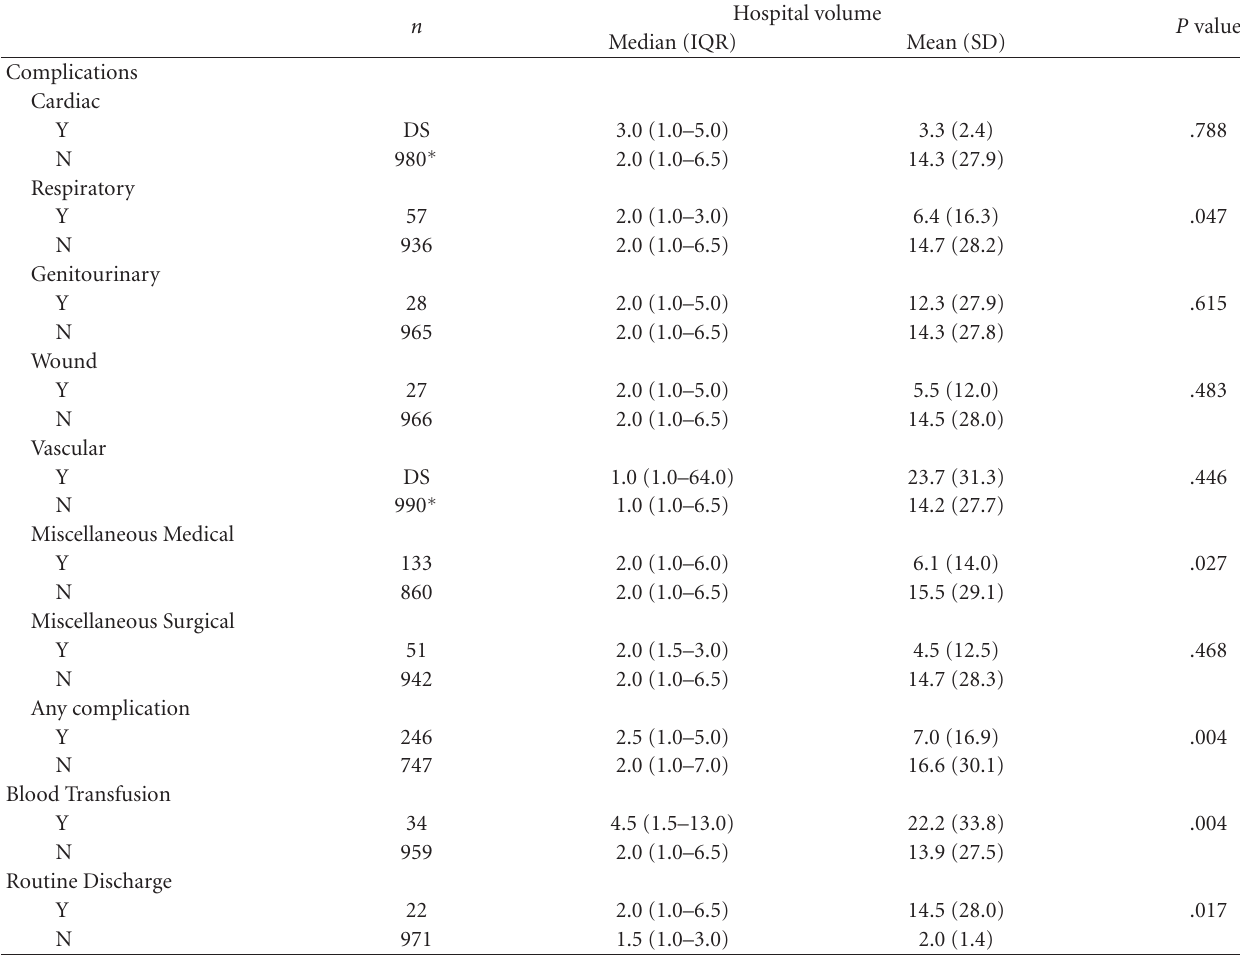
Table 3: RPLND outcomes by continuous hospital